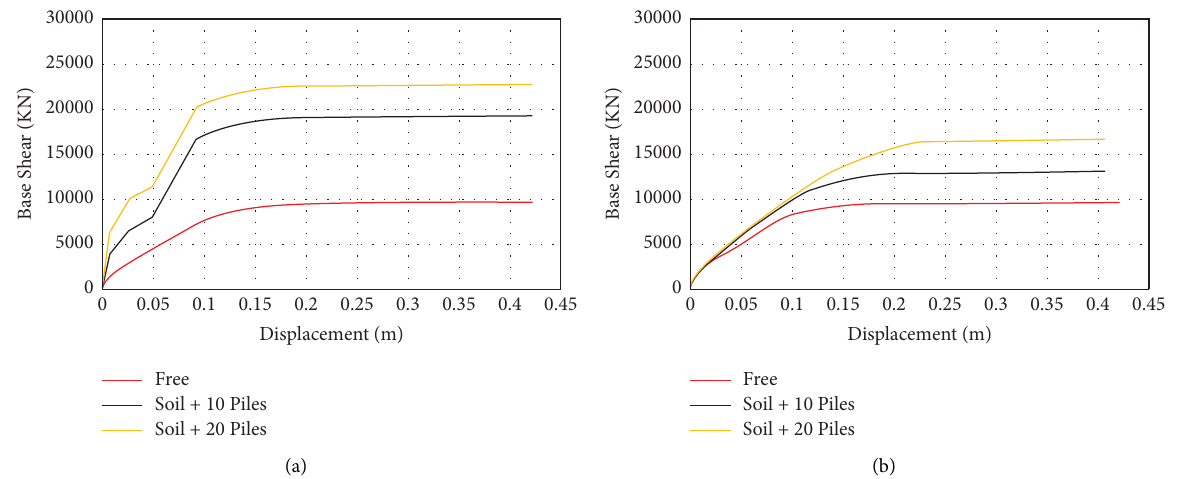
Figure 9: Pushover curves of F0, L0, and H0 bridge models in (a) longitudinal and (b) transverse directions.